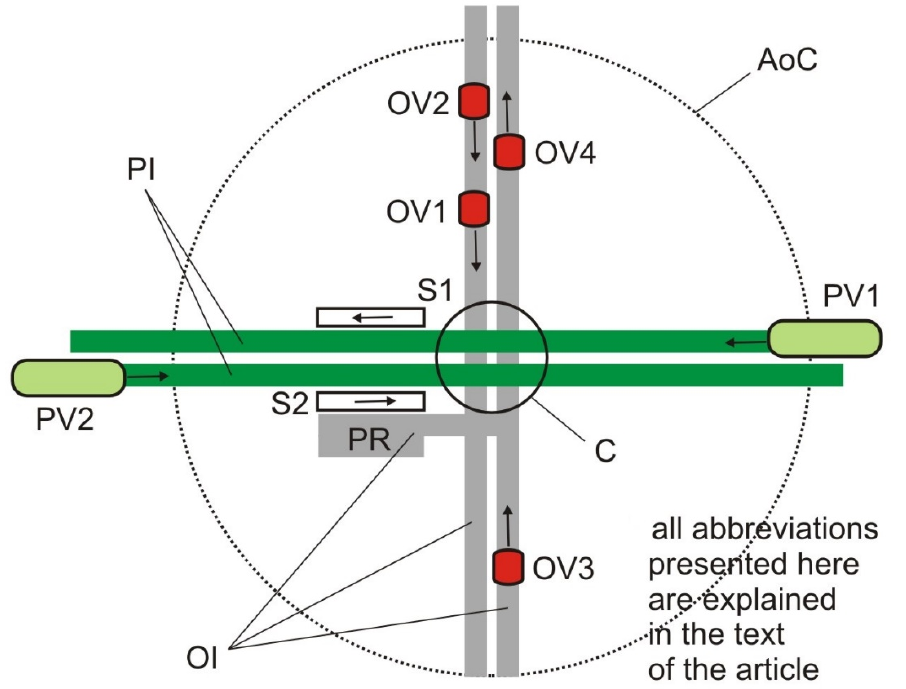
Figure 6. The model for case 3: Vicinity of the railroad crossing .